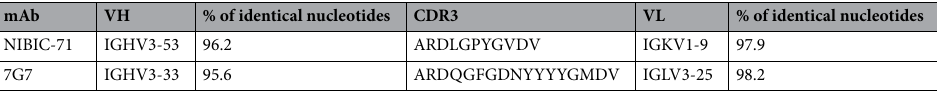
Table 1. Gene usage and CDR3 sequence of NIBIC-71 and 7G7. Each mAb was compared to germline DNA and amino acid sequences. mAb, monoclonal antibody; VH, variable region of the heavy chain; VL, variable region of the light chain; CDR, complementarity determining region; nt: